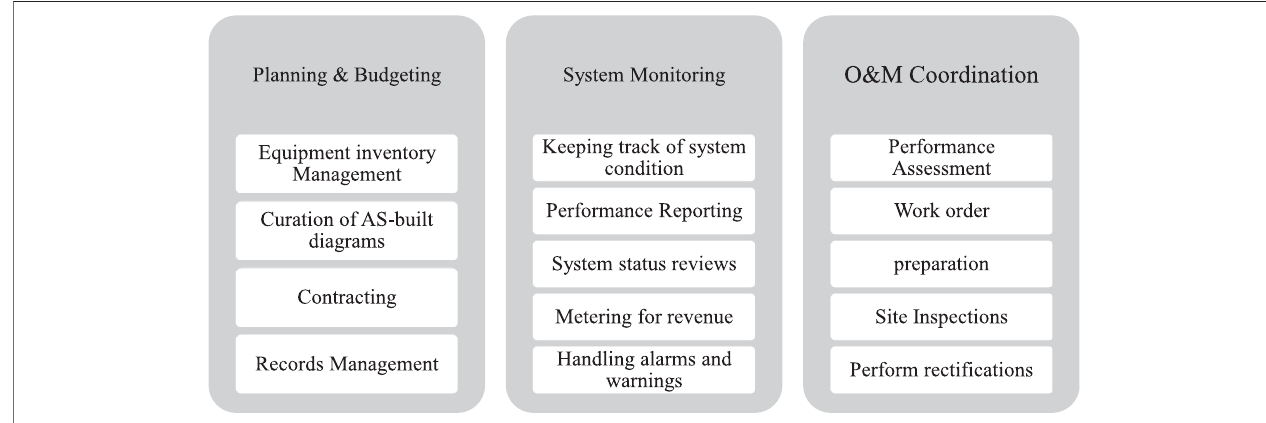
FIGURE 5 | Integral aspects in operation of solar PV fl eet Solar Power Europe [SPE] 2018.